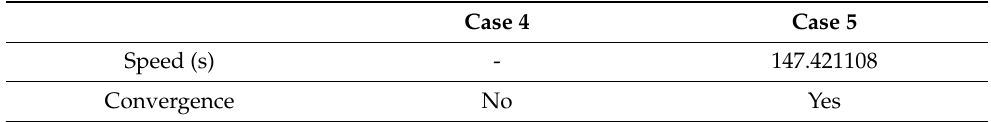
Table 4. Model convergence of